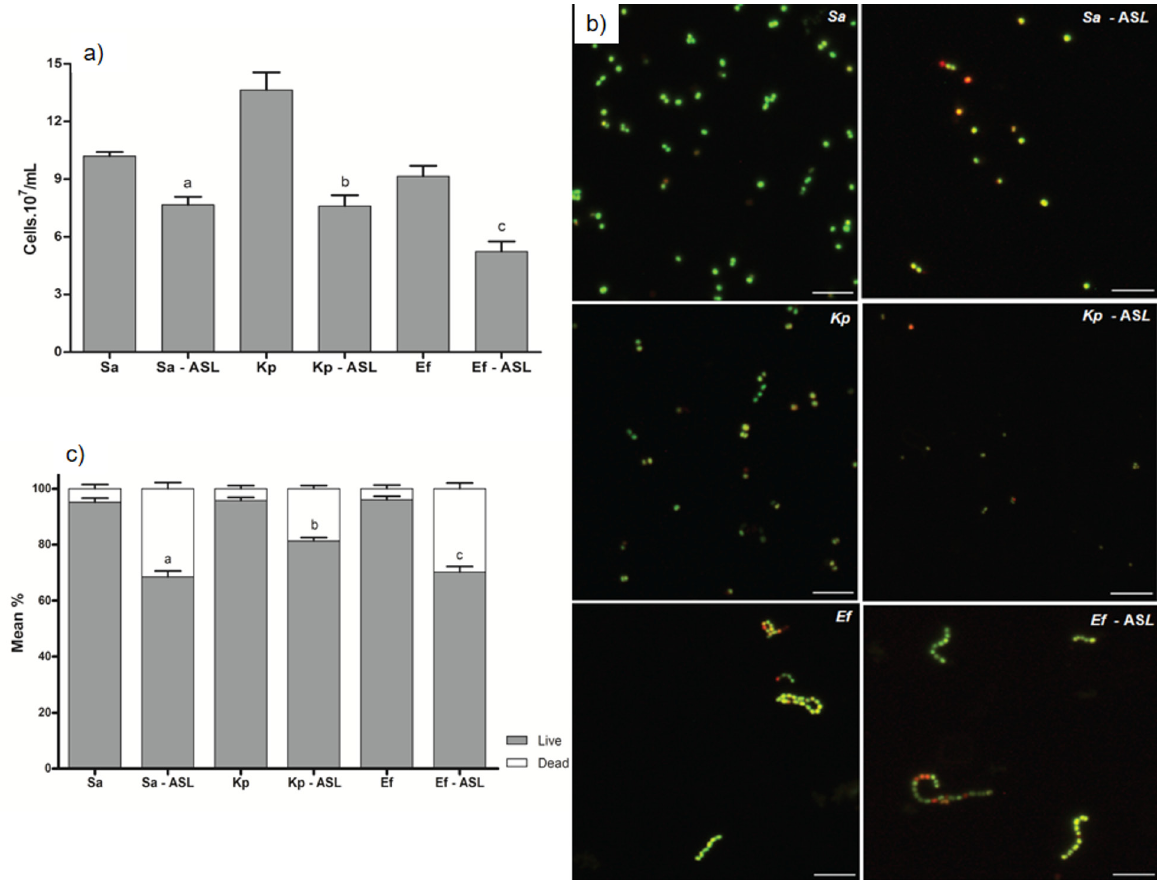
Figure 7 - Effect of methanolic extract of Annona squamosa leaves (ASL) on bacterial growth of S. aureus , K. pneumoniae and E. faecalis . a ) Bacteria density evaluated after staining with DAPI. b ) Live/dead bacteria were clearly observed as green or red structures. c ) The percentage of live/dead cells are shown. Scale bar 10µm. a Statistically different from growth control of S. aureus . b Statistically different from growth control of K. pneumoniae . c Statistically different from growth control of E. faecalis (ANOVA followed by Bonferroni, P < 0.05). All experiments were carried out in triplicate, and average values are reported. Error bars refer to the standard